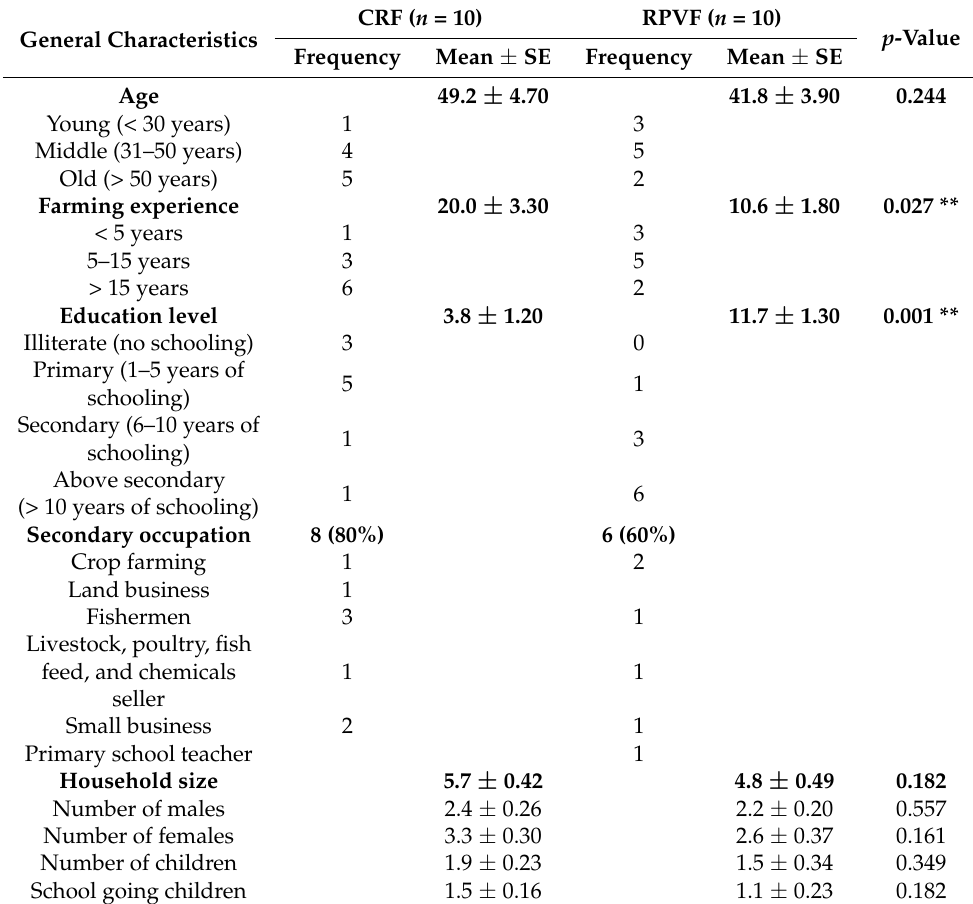
Table 2. Demographic and socioeconomic features of farmers of conventional rice farms (CRF) and rice–prawn–vegetable farms